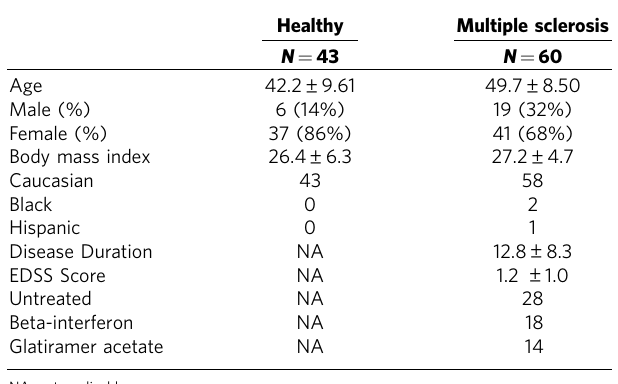
Table 1 | Demographics of study population.